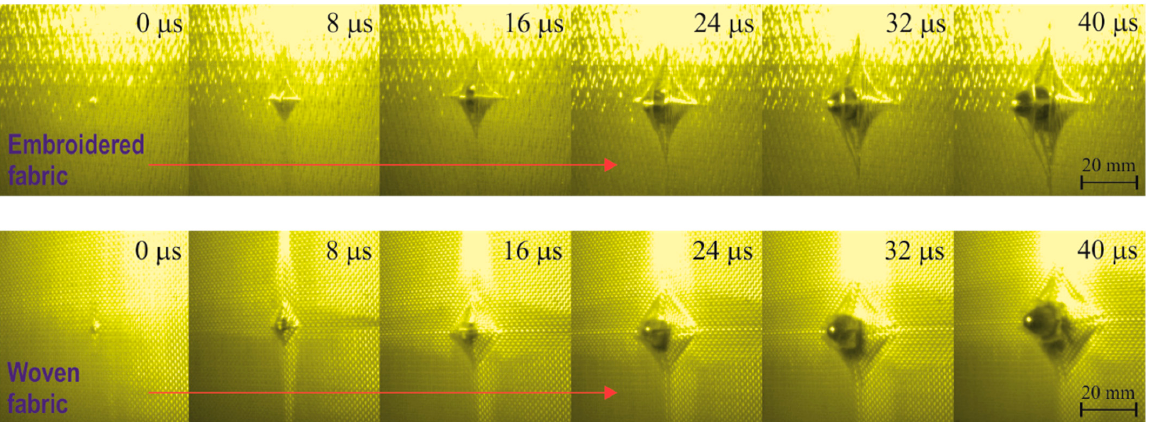
Figure 5. Stages of piercing a para-aramid embroidered and woven structure with a bullet, recorded with a high-speed camera.